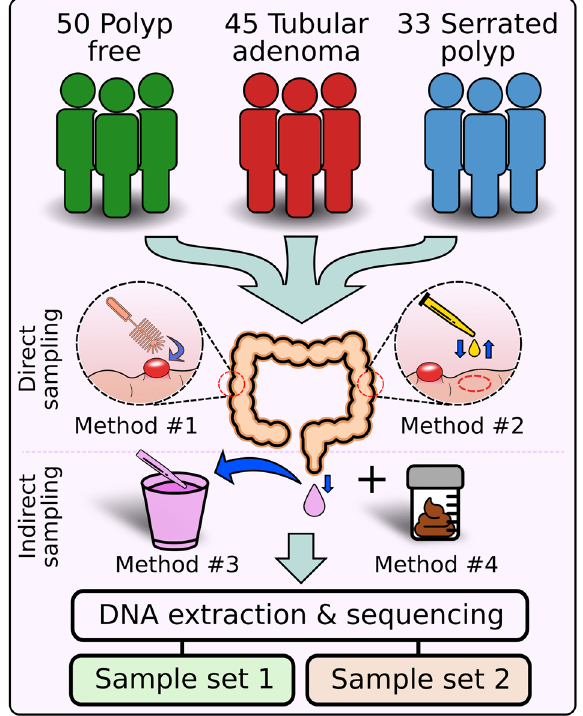
Fig. 1 Study design. A total of 140 individuals were recruited for this study, including 50 polyp-free individuals, 45 with tubular adenomas, and 33 with serrated polyps (HPP, TSA, or SSP). The remaining 12 individuals had missing or unknown pathologies. Multiple samples were taken from each subject during colonoscopy. This included mucosal brushes (Method #1, orange), mucosal aspirates (Method #2, yellow), and lavage aspirates (Method #3, purple). Fecal samples (Method #4, brown) were collected from participants 4 to 6 weeks post-colonoscopy. DNA extraction and sequencing produced two sample sets. The fi rst sample set was produced by sequencing mucosal brushes, mucosal aspirates, and lavage aspirates using 16S and ITS sequencing. The second sample set was produced by sequencing mucosal aspirates, lavage aspirates, and fecal samples using whole-genome shotgun